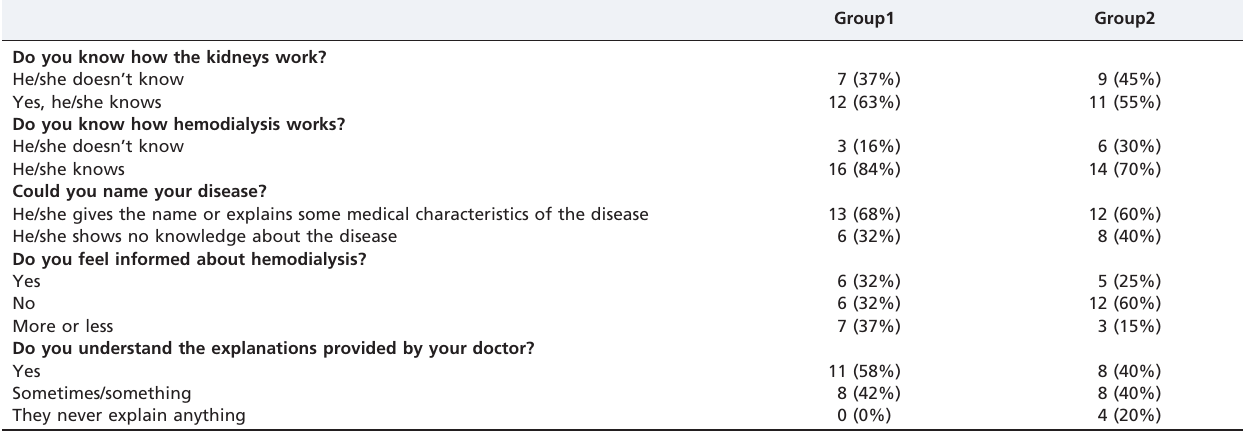
Table 3 - Knowledge about renal function and hemodialysis.